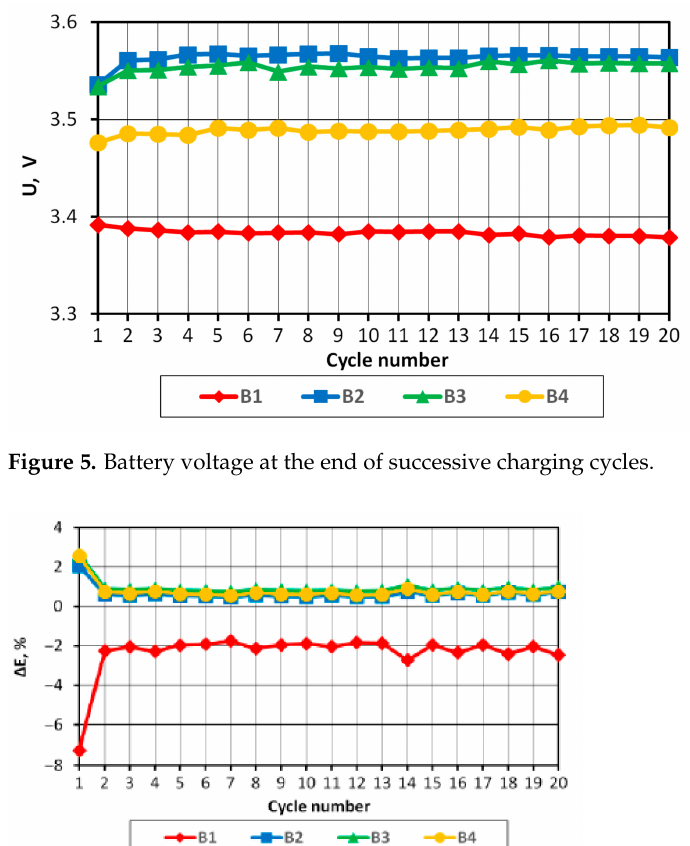
Figure 4. Battery voltage at the end of successive discharging cycles.